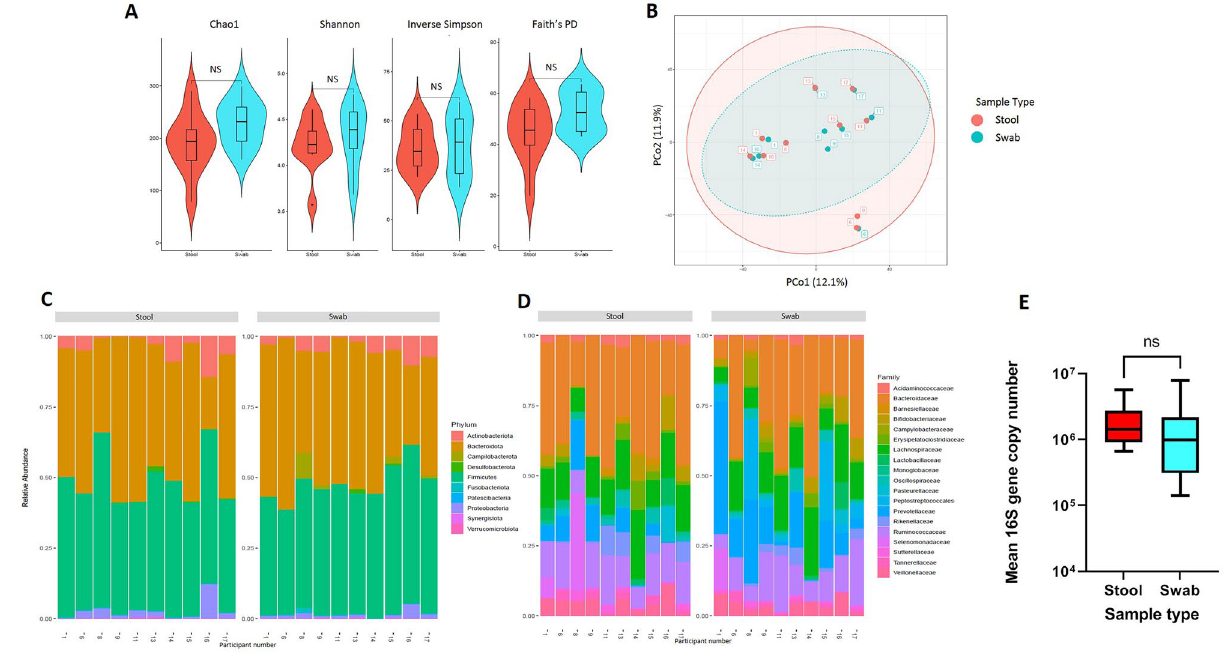
Figure 1. Comparison of compositional analysis of the gut microbiome, as assessed by matched faeces vs rectal swabs. ( A ) Alpha diversity metrics (Kruskal–Wallis). ( B ) Beta diversity, as represented by PCoA (numbers on points within figure represent study participant number). ( C ) Relative abundance plots of all bacterial phyla. ( D ) Relative abundance plot of major bacterial families (filtering used to remove families present at < 5% relative abundance; numbers on horizontal axis represent study participant number). ( E ) 16S rRNA gene copy number. Faeces: n = 10 samples; swabs: n = 10